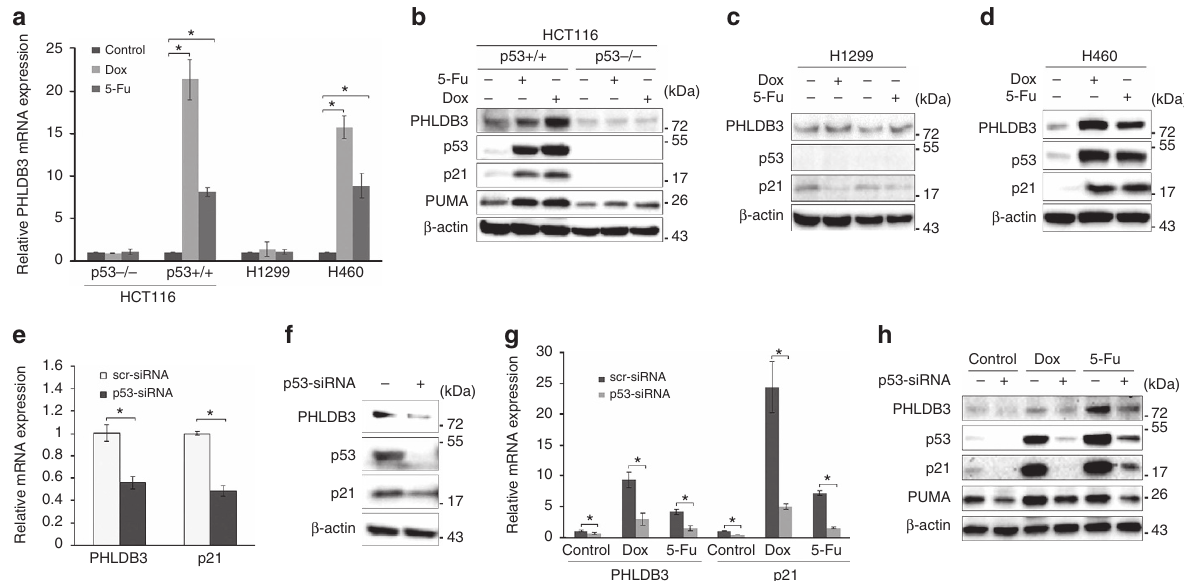
Figure 1 | PHLDB3 is induced by chemotherapy drugs in a p53-dependent manner. ( a – d ) Analysis of PHLDB3 mRNA and protein levels following chemotherapy drugs treatment. HCT116, H1299 and H460 cells were treated with Doxorubicin (Dox) or 5-Fluorouracil (5-Fu) for 16h for analyses of RNA and protein levels. The mRNA levels of PHLDB3 were measured using RT-qPCR ( a ). The protein levels of PHLDB3, p53 and p53 targets were detected using immunoblotting analysis with indicated antibodies ( b – d ). ( e , f ) Analysis of PHLDB3 mRNA and protein levels after p53 knockdown. H460 cells were transfected with p53 or scramble siRNA, and cells were harvested 72h post-transfection for RT-qPCR ( e ) or immunoblotting with indicated antibodies ( f ). ( g , h ) The effect of p53 knockdown on the PHLDB3 mRNA ( g ) and protein levels ( h ) after treatment of HCT116 p53 þ / þ cells with chemotherapy drugs. HCT116 p53 þ / þ cells were transfected with p53 or scramble siRNA for 72h, and treated with Dox or 5-Fu for 16h before the cells were harvested for RT-qPCR ( g ) or immunoblotting with indicated antibodies ( h ). Where applicable, data were corrected for GAPDH and represent mean ± s.e.m. of triplicate experiments. * P o 0.05 by two-tailed t -test ( a , e , g ).